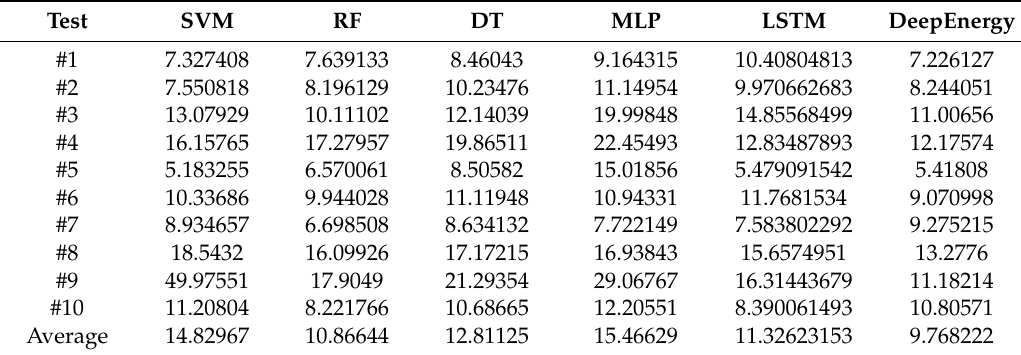
Table 1. The experimental results in terms of Mean Absolute Percentage Error (MAPE) given in percentages.